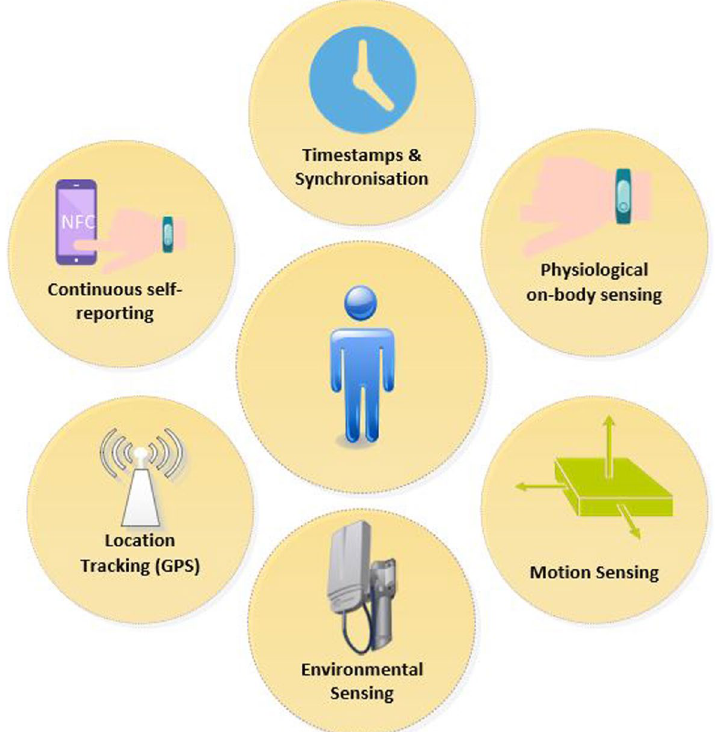
Fig. 2 Data Collection methods to support DigitalExposome